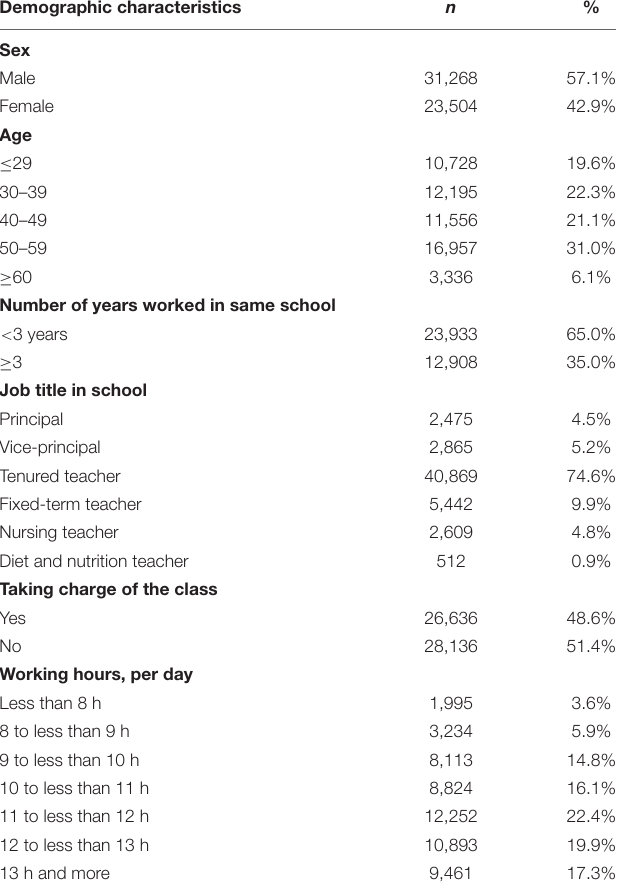
TABLE 1 | Characteristics of junior high school